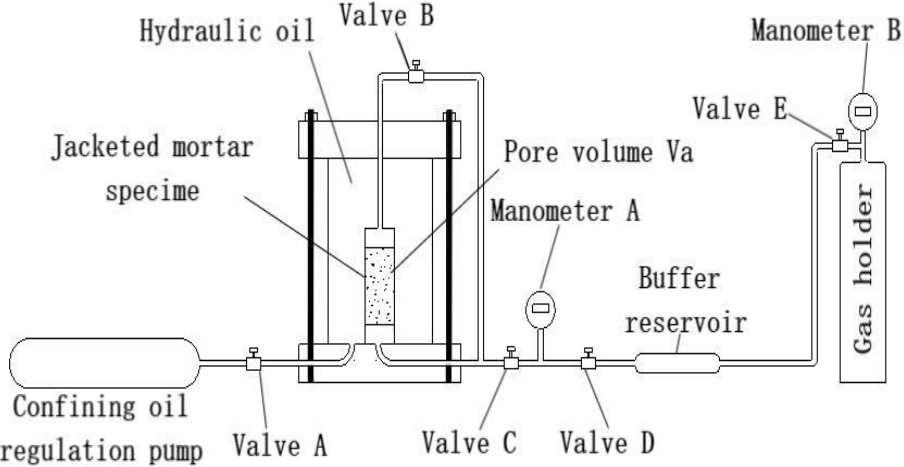
Figure 3. Schematic diagram of gas permeation test device